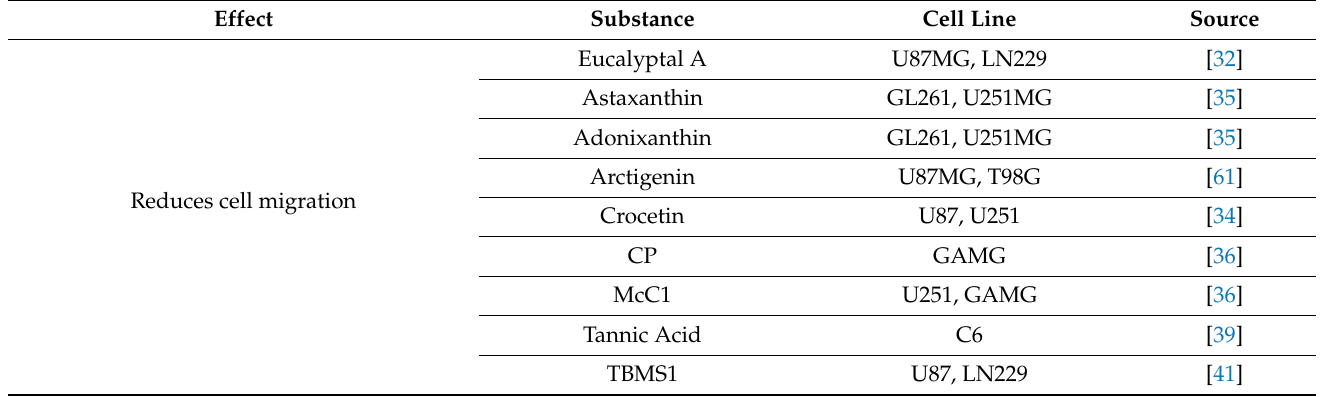
Table 8. Natural substances decrease GBM cell migration and invasion by downregulating EMT modulators (Snail, Slug, and MMPs), Cofilin inhibitors (RhoA/ROCK/Limk and PKA), and actin polymerizers